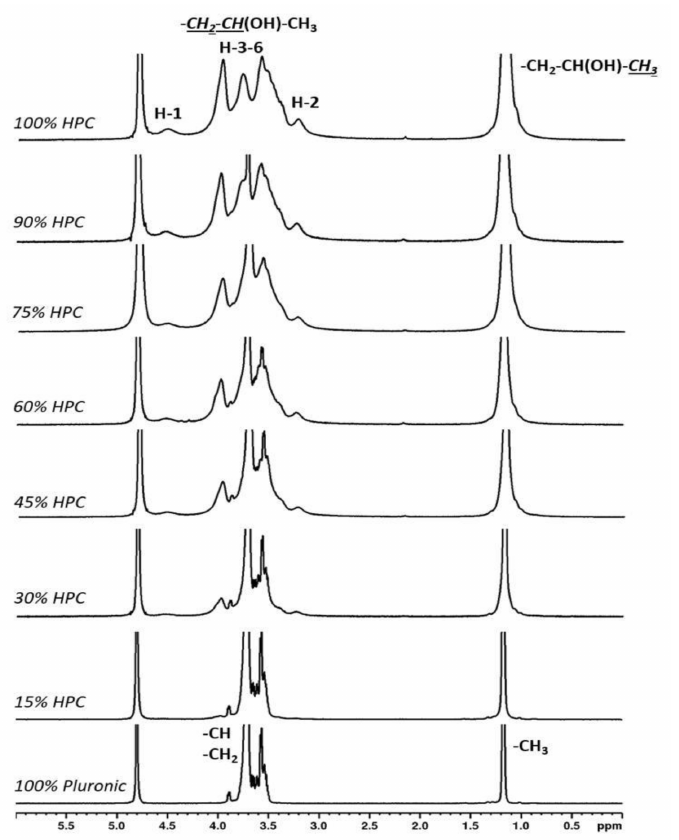
Figure 2. 1 H NMR spectra of hydrogel blends with different additions of HPC in their